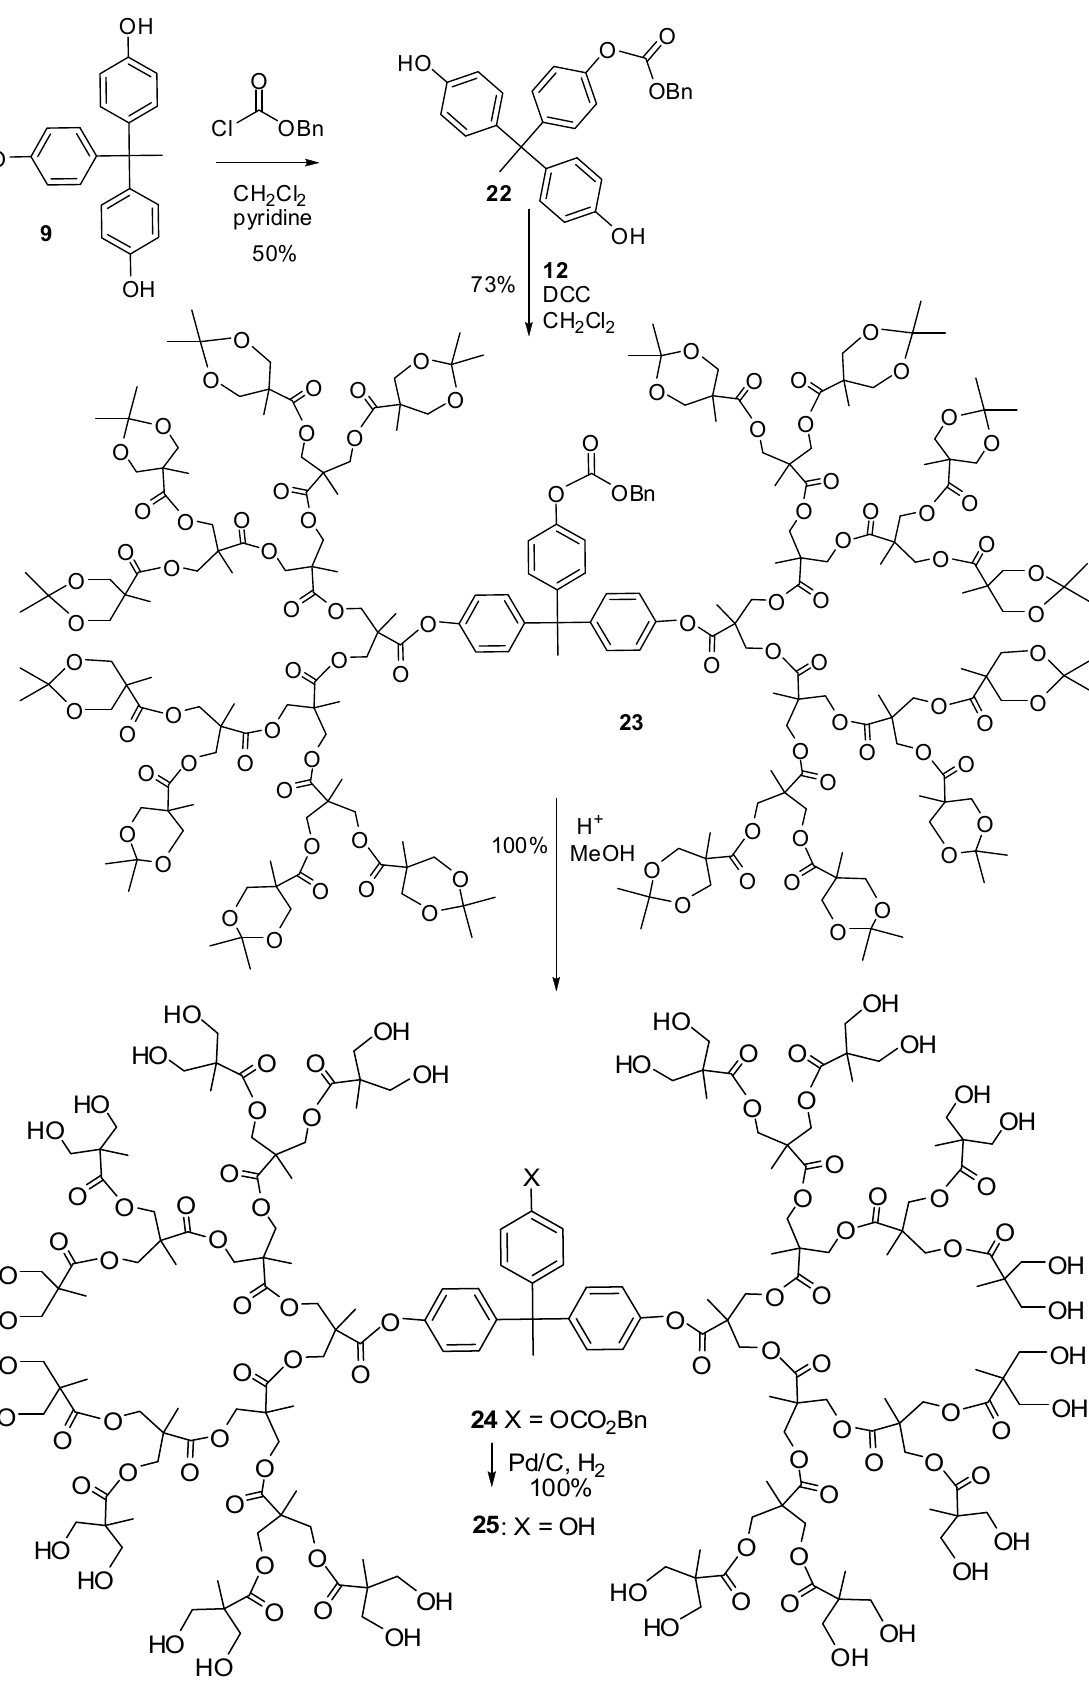
Scheme 15. Preparation of a divalent fourth generation polyester dendrimer (first section) and its surface functionalization (second section)